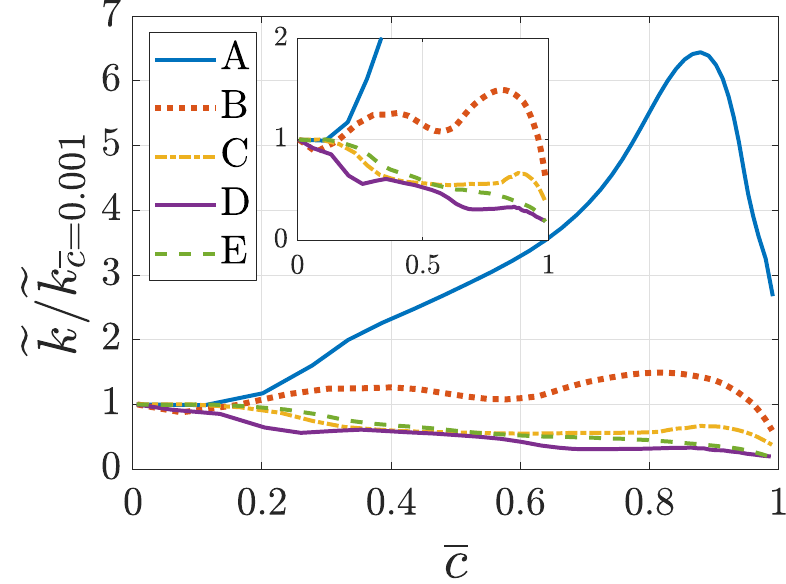
k/ k with Reynolds c =0 . 001 e e